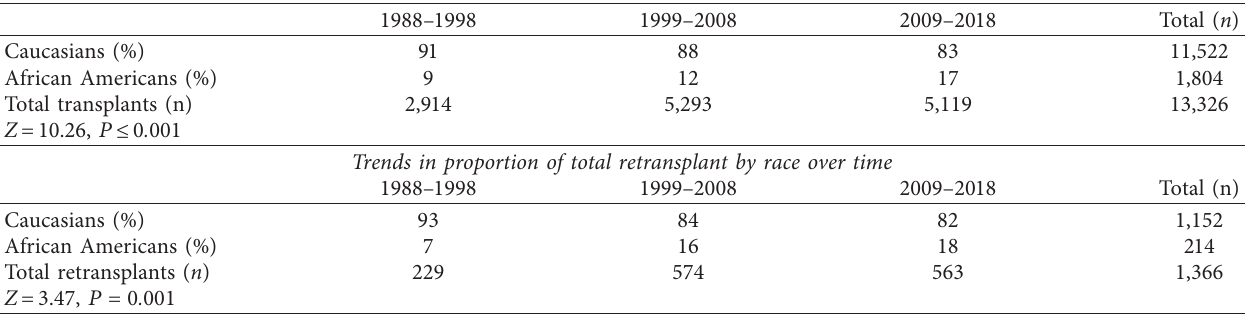
Table 6: Trends in proportion of total liver transplant by race over